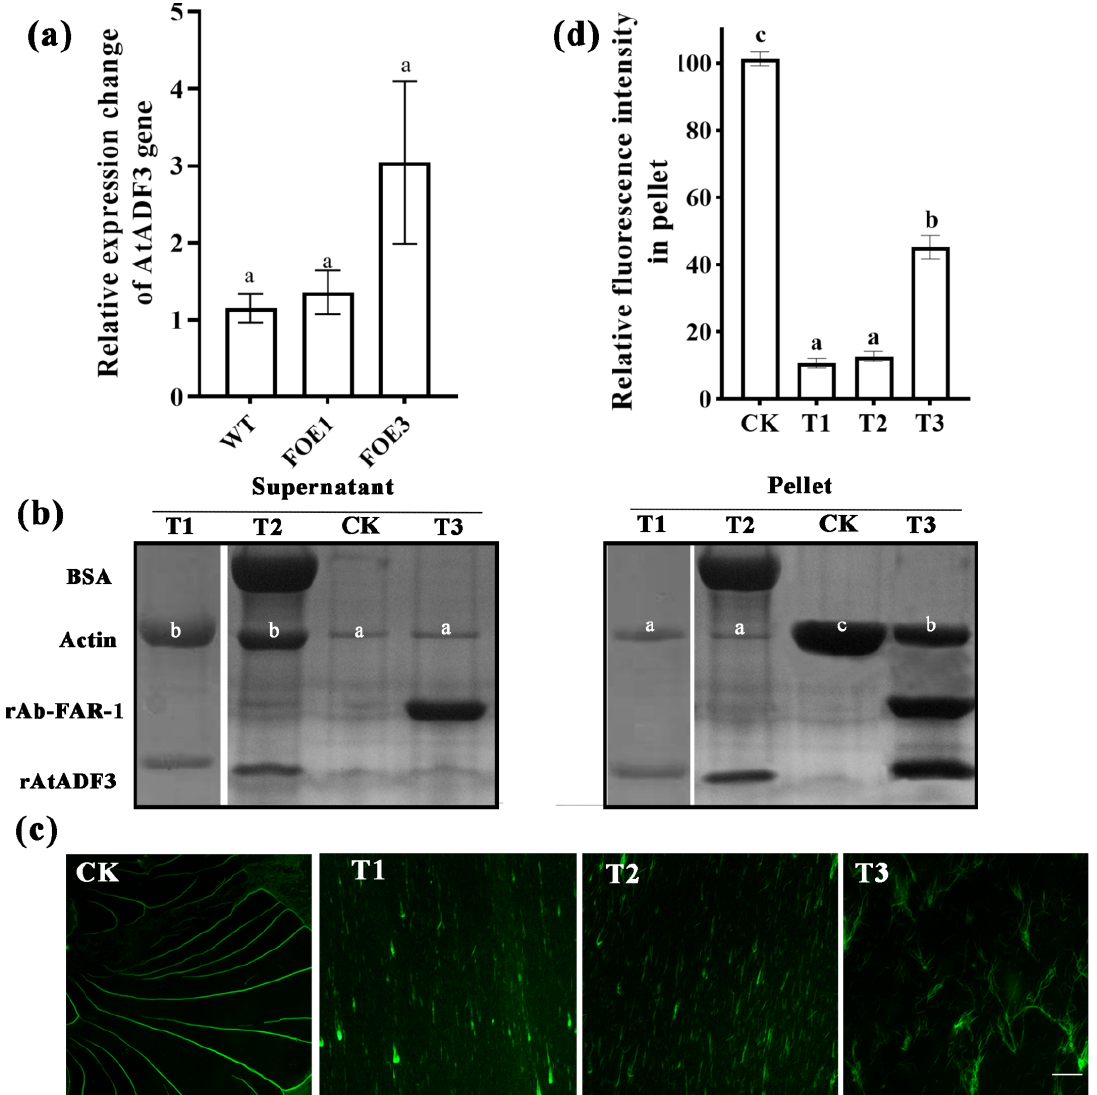
Figure 8. Ab-FAR-1 Δ sp can inhibit AtADF3-mediated F-actin depolymerizing function. ( a ) Overexpression of Ab-FAR-1 Δ sp was not affected by the transcription level of AtADF3. ( b ) The F-actin depolymerizing activities of AtADF3 were determined using high-speed co-sedimentation assays; F-actin filaments were incubated with different treatments (CK, T1-T3). The pellet and supernatant fractions were analysed by SDS–PAGE. CK, 4 μ M F-actin alone; T1, 6 μ M rAtADF3/ 4 μ M F-actin; ( c ) Direct visualization of F-actin in pellet by Alexa-488-phalloidin staining method. Bar = 20 µ m. ( d ) The content of actin was quantified by fluorescence intensity. There were three independent biological replicates. Different letters above bars denote values that are significantly different from each other ( p < 0.05, Tukey’s test).